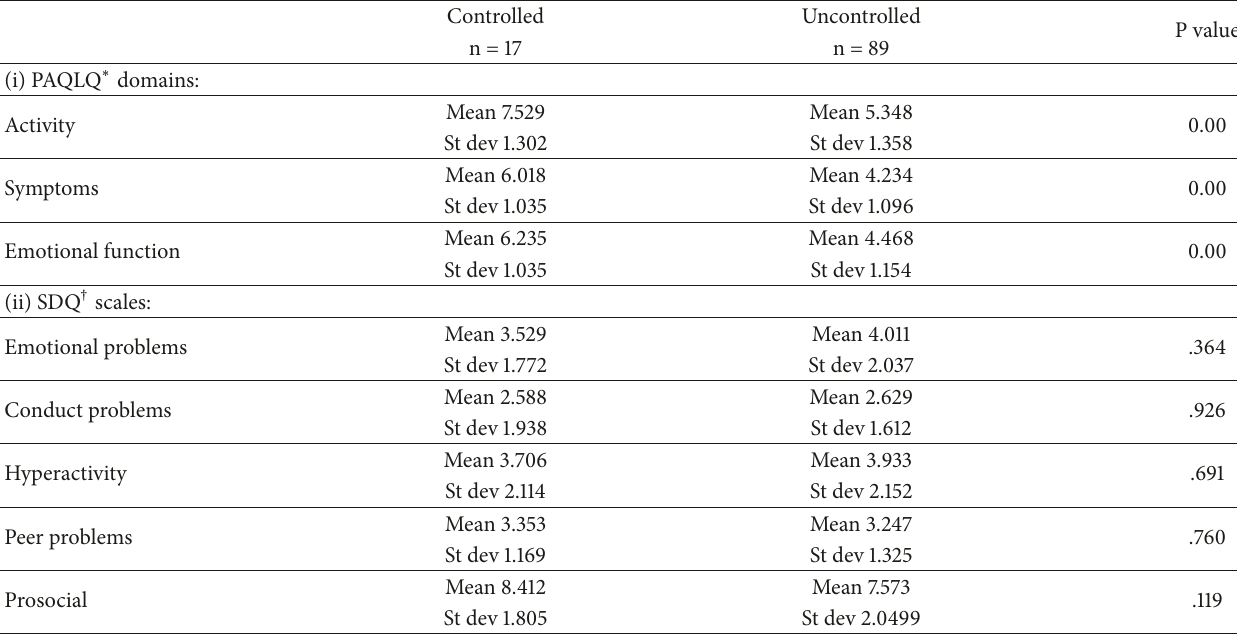
to asthma control status.